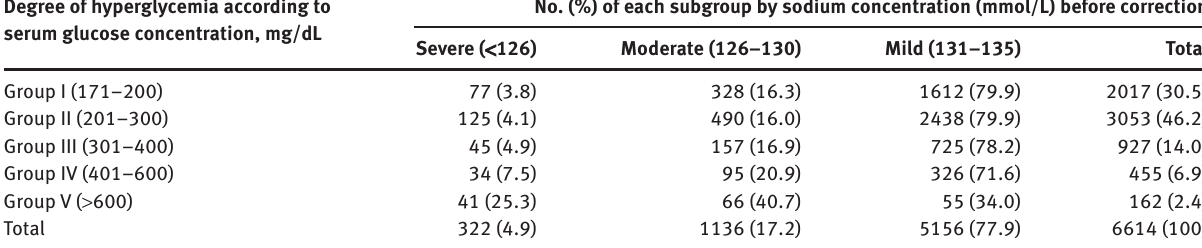
Table 1: Distribution of initial serum sodium concentrations before correction. Degree of hyperglycemia according to